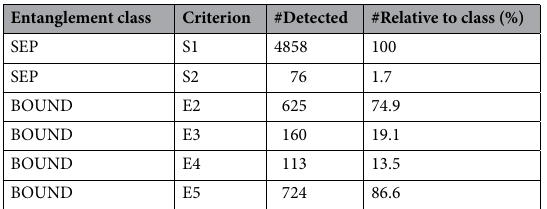
Table 3. BOUND and SEP detectors and their relative number in class.